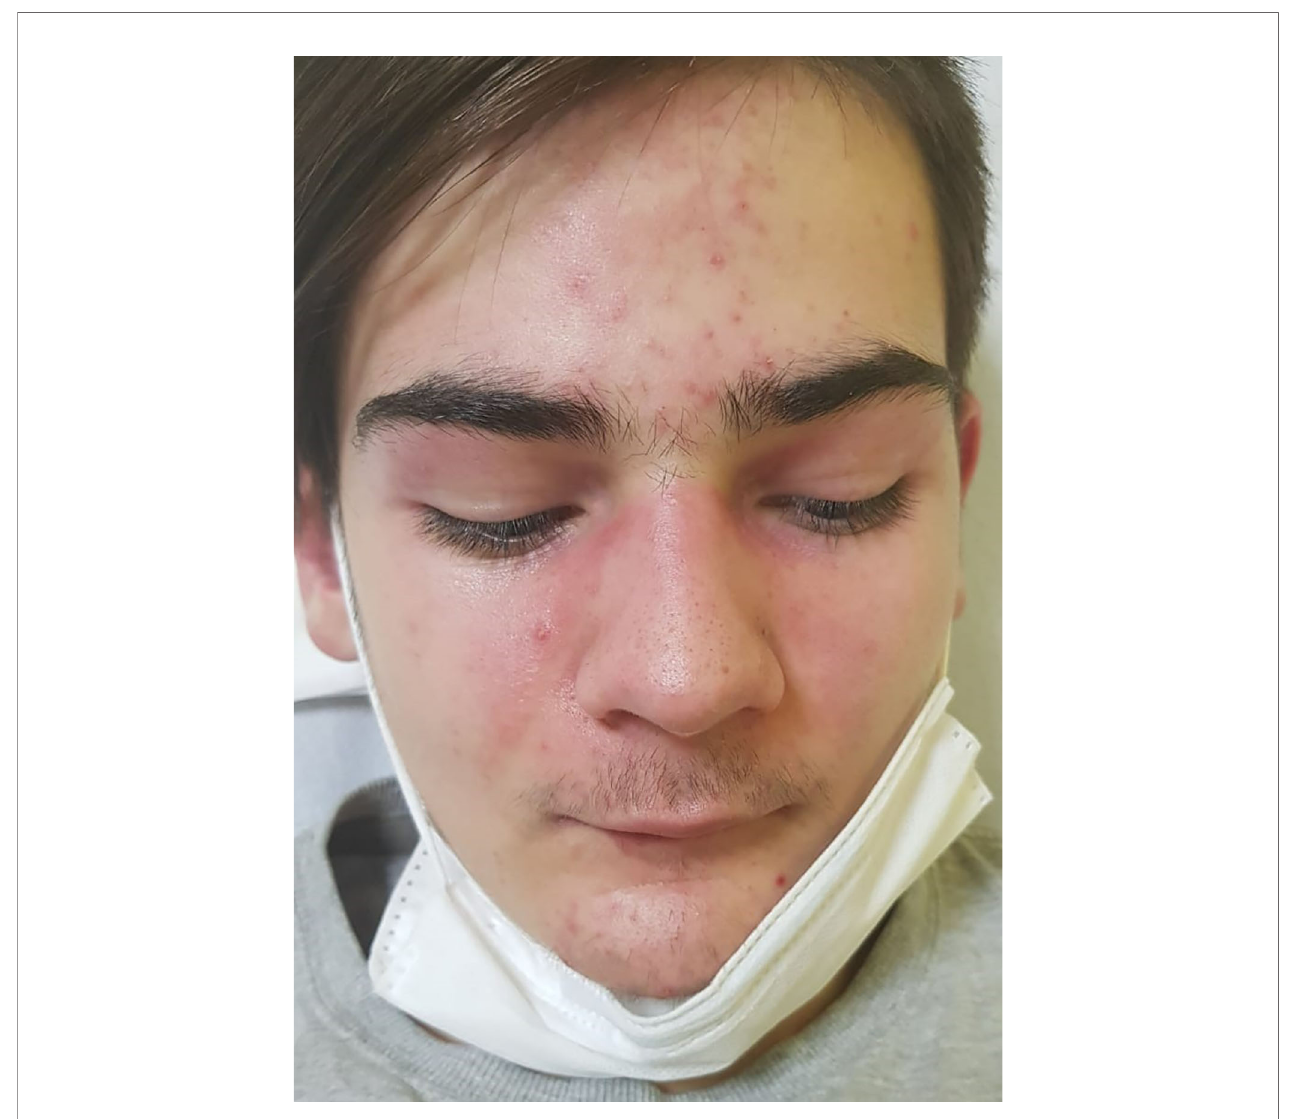
FIGURE 2 | Characteristic cutaneous features of DM called heliotrope rash (violaceous erythema of the eyelids or periorbital skin) and the malar